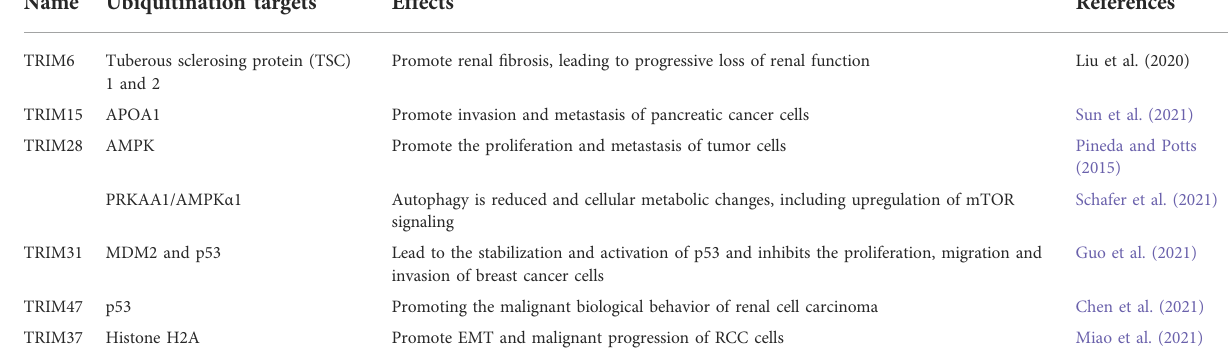
TABLE 1 Relationship between TRIMs and